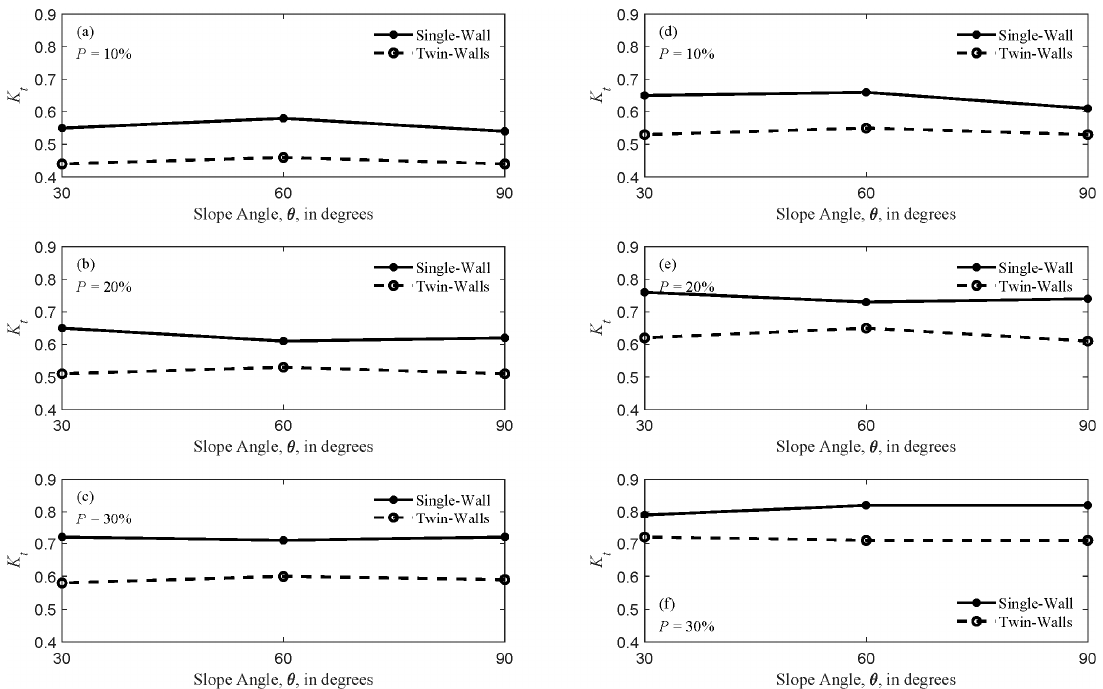
Figure 6. Variation of K t with θ for d / L p = 0.1529 and different porosities and wall configurations. On the left, H is / d = 0.2493 ( a , b , and c ) and on the right H is / d = 0.1284 ( d , e , and f ).